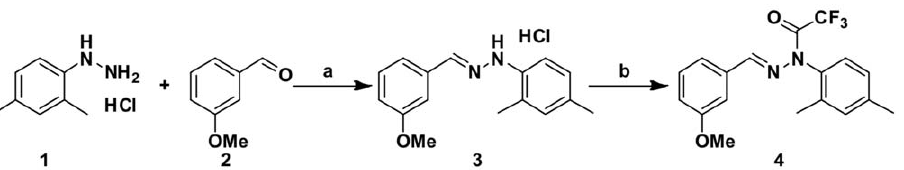
Figure 10. Preparation of J147. J147 was prepared as described in the chemistry section of the materials and methods. The reagents and conditions for each step are as follows: (a) EtOH, rt, 1 h, 90%; (b) (CF 3 CO) 2 O, Et 3 N, 30 min, 10 u C,